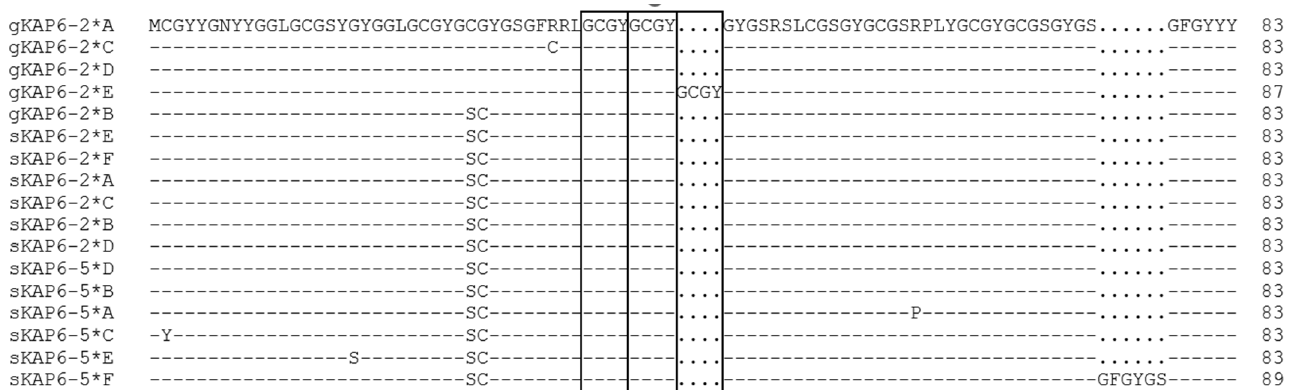
Figure 4. Alignment of the predicted amino acid sequences of the KRTAP6-2 and KRTAP6-5 variants identified in goats and sheep. Amino acids are represented in one letter code. Dashes represent amino acids identical to the top sequence and dots represent the absence of amino acids. The goat sequences are indicated with a prefix ‘g’, and the sheep sequences are with a prefix ‘s’. The GenBank accession numbers for sheep KRTAP6-2 ( A – F ) are KT725827–KT725832, and those for sheep KRTAP6-5 ( A – F